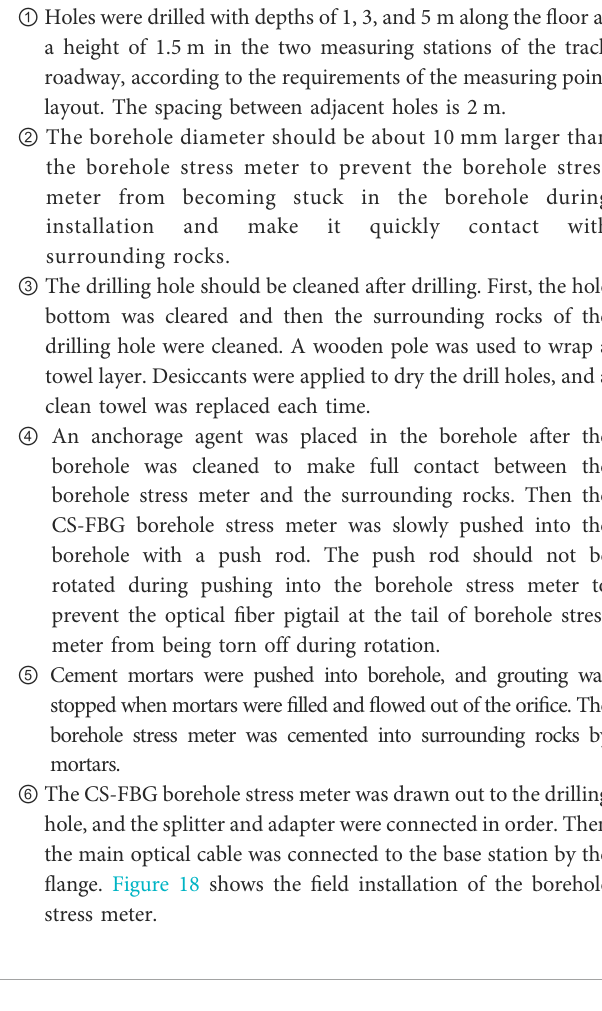
FIGURE 16 Deformation of borehole stress meter after the test.